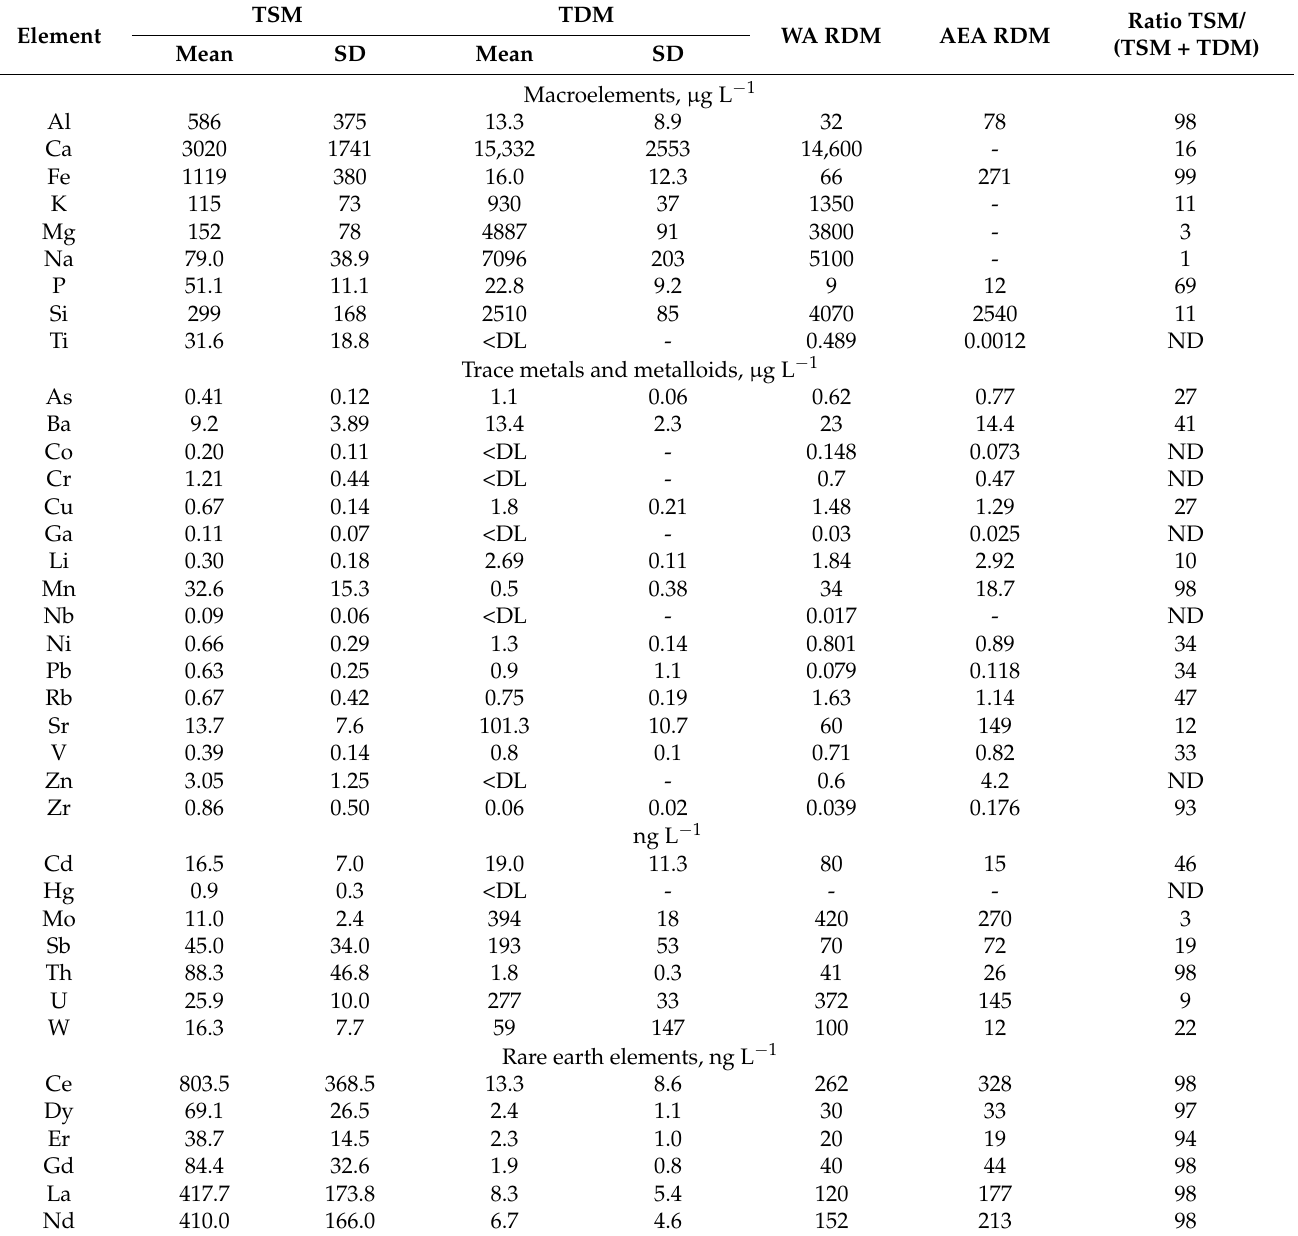
Table 3. Content of chemical elements in suspended and dissolved forms, Ob, August 2020 (n =